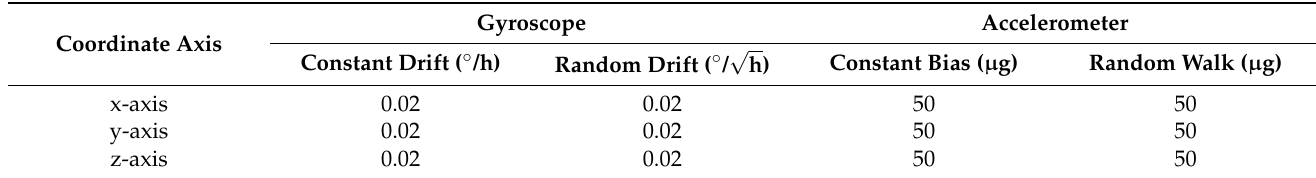
Table 1. Parameters settings of IMU.